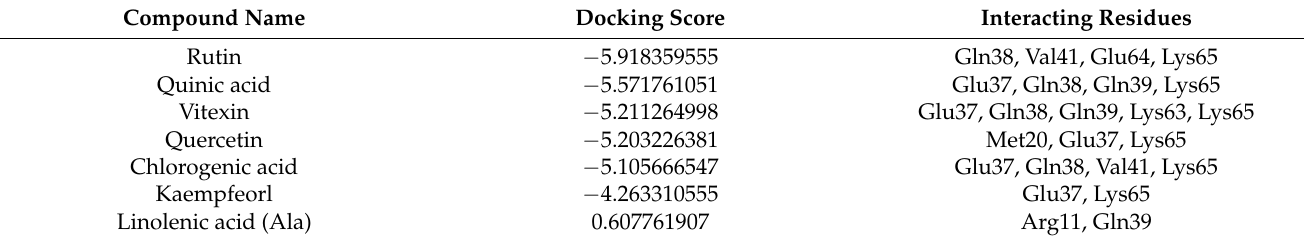
Table 7. The docking site and interaction residues of compounds with IL-1 β active